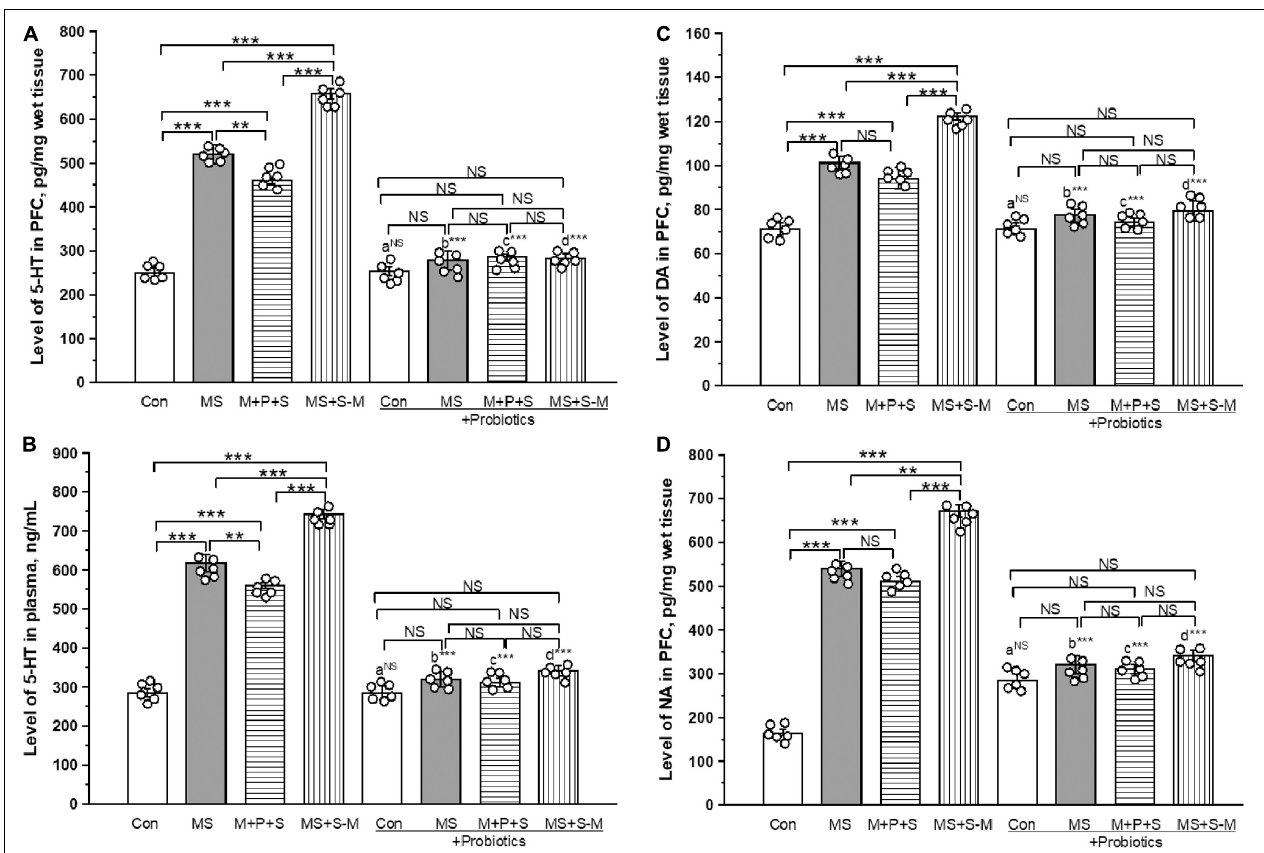
FIGURE 6 | Lactobacillus supplementation prevented the effect of early life SSE on the level of 5-HT in PFC (A) , 5-HT in plasma (B) , DA in PFC (C) , and NA in PFC (D) . Values are presented as mean ± SEM. Significant differences between groups are indicated by *** P < 0.001, ** P < 0.01, a: con vs. con + Pro; b: MS vs. MS + Pro; c: M + P + S vs. M + P + S + Pro; d: MS+S–M vs. MS+S–M + Pro; NS, not